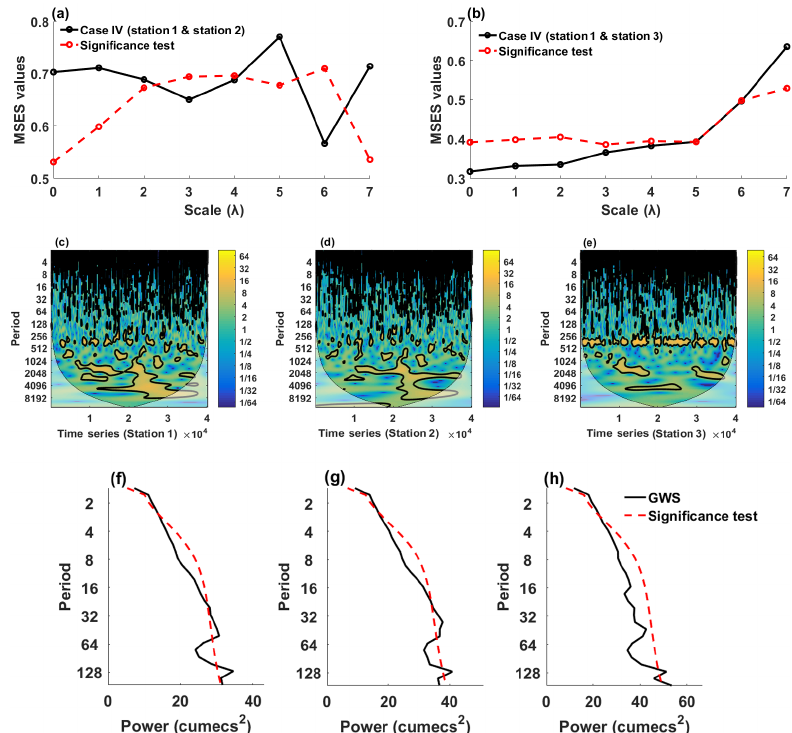
Figure 9. (a, b) MSES and significance level (1%) values at various scales for stations 1 and 2 and stations 1 and 3, respectively; (c, d, e) WPS of precipitation of stations 1 (c) , 2 (d) , and 3 (e) (station ID: 20009, 20208, 25005), respectively; (f, g, h) global wavelet spectrum of the same stations. In (c) – (h) the y -axis represents the corresponding Fourier period = 2 λ